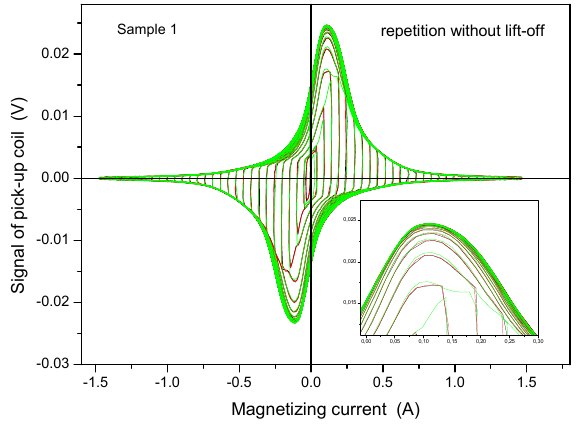
Figure A1. Series of permeability loops measured on sample 1, repeating the measurement after each other without replacing the sample. Insert: magnified part of the graph.